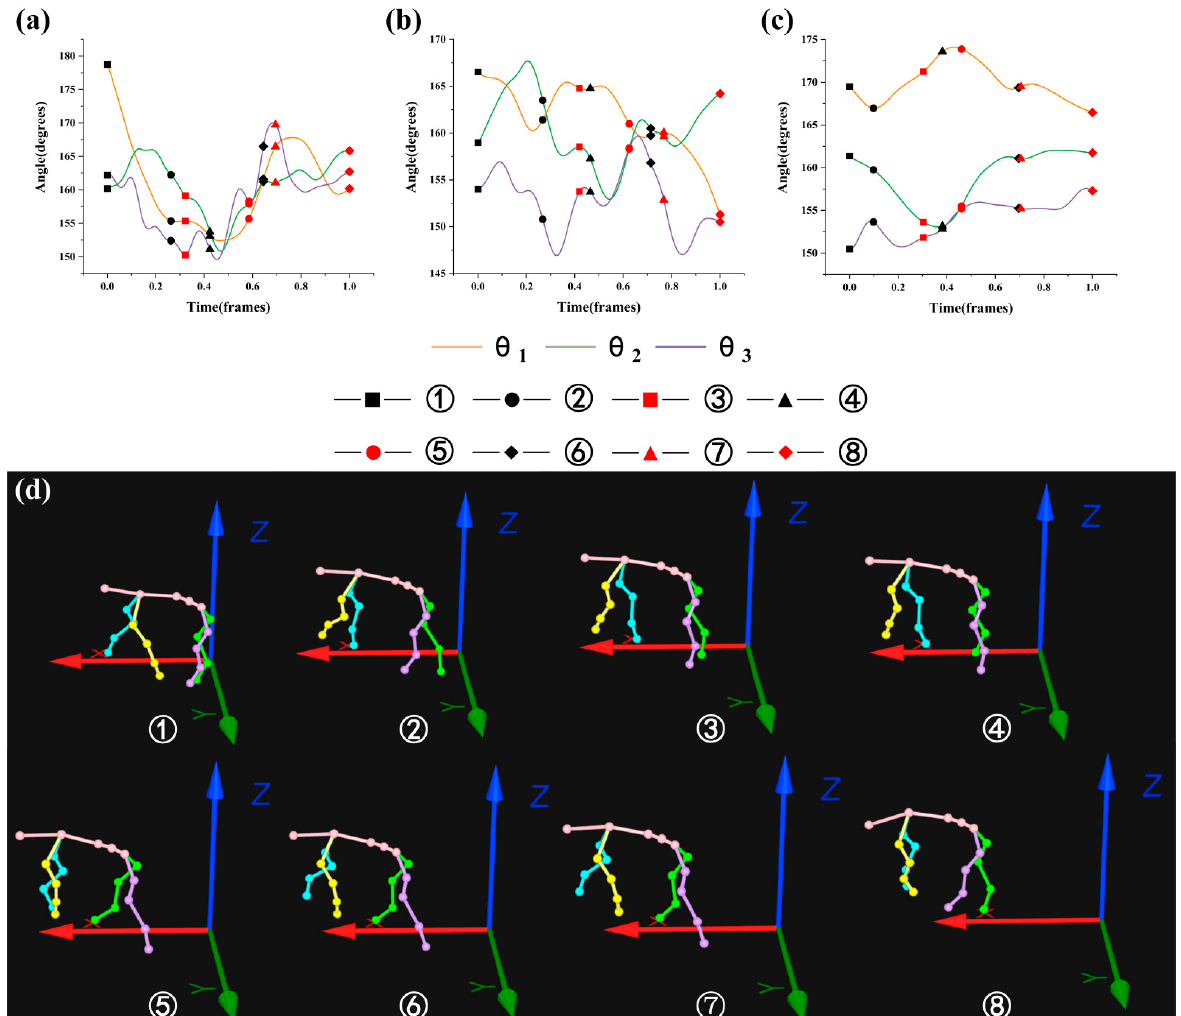
Figure 8. Motion state of goat: ( a – c ) are angle changes of θ 1 , θ 2 , and θ 3 under the slope of 15°; ( d ) eight movements under the slope of 15°. ( d ) eight movements under the slope of 15 ◦ .